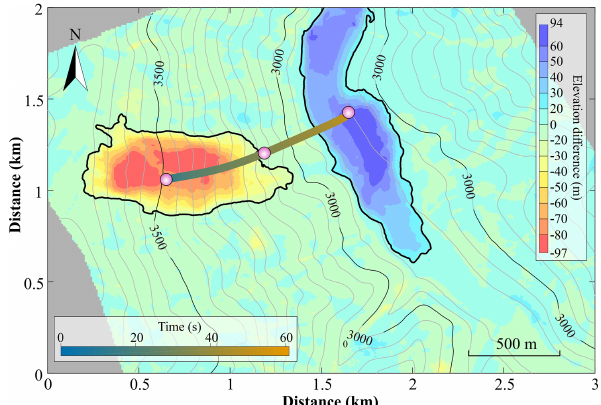
Figure 10. Reconstructed horizontal trajectory of the Baige land- slide from the seismic dynamic inversion. The base map is the eleva- tion difference derived from DEMs, and the reconstructed trajectory is shown by the colored dots and connecting